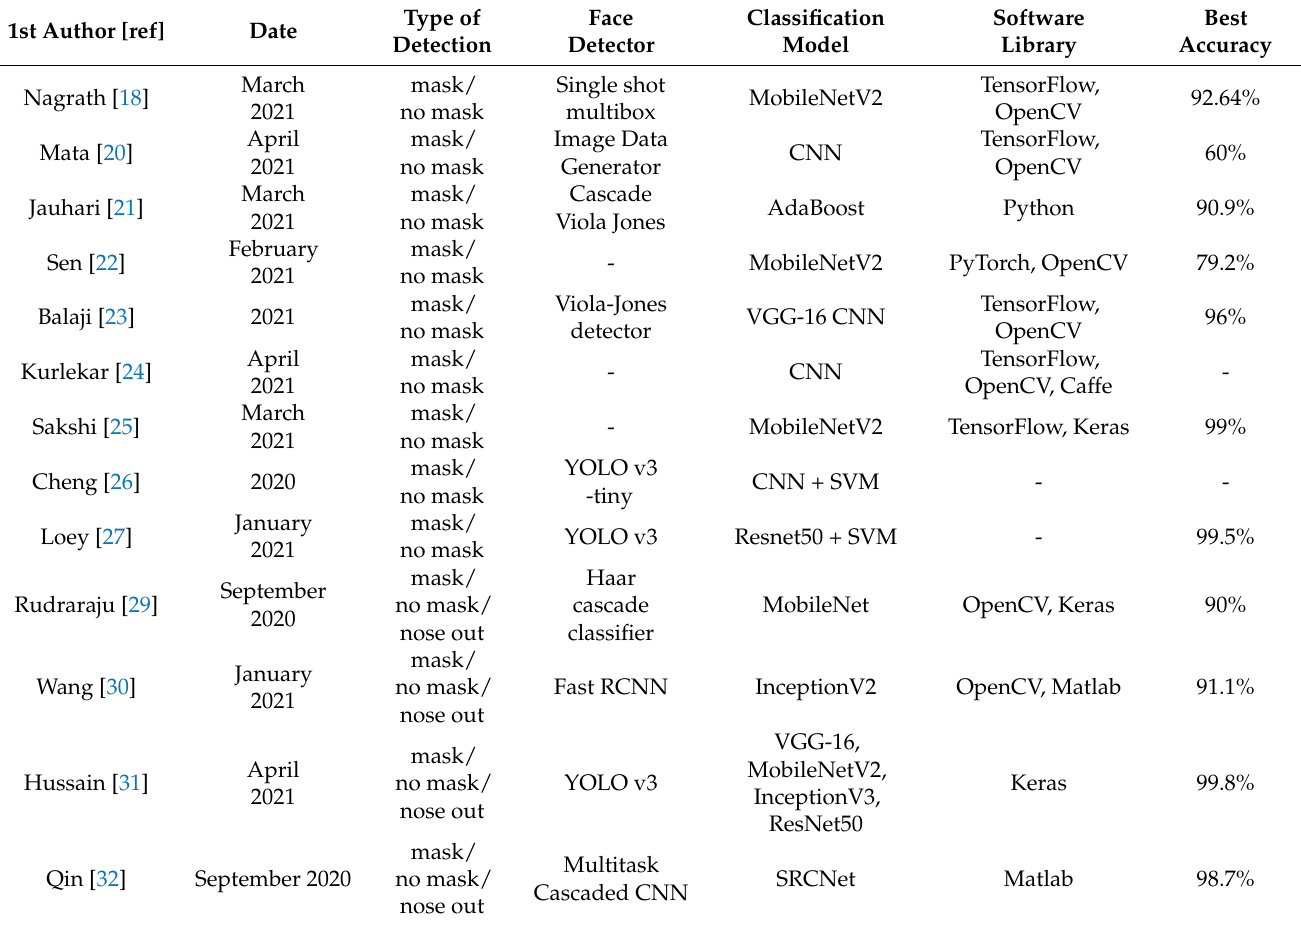
Table 1. Summary of the related